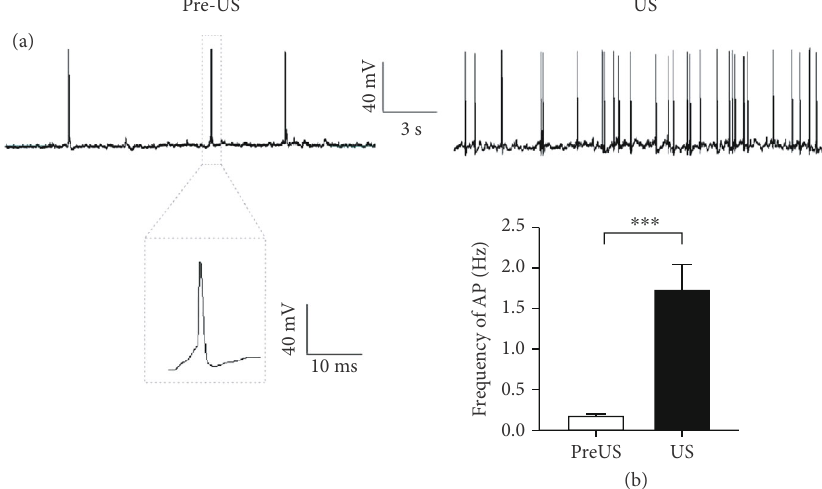
Figure 3: Ultrasound stimulation elicits action potentials in cultured cortical neurons. (a) Representative traces show the action potentials of a cultured cortical neuron before (pre-US) and during (US) US stimulation. Inset shows the shape of the action potential. (b) The mean frequencies of the action potentials of spontaneous fi ring (pre-US) and during (US) US stimulation. Data are presented as the mean ± SE . ∗∗∗ p < 0 : 001 , n = 9 , paired t